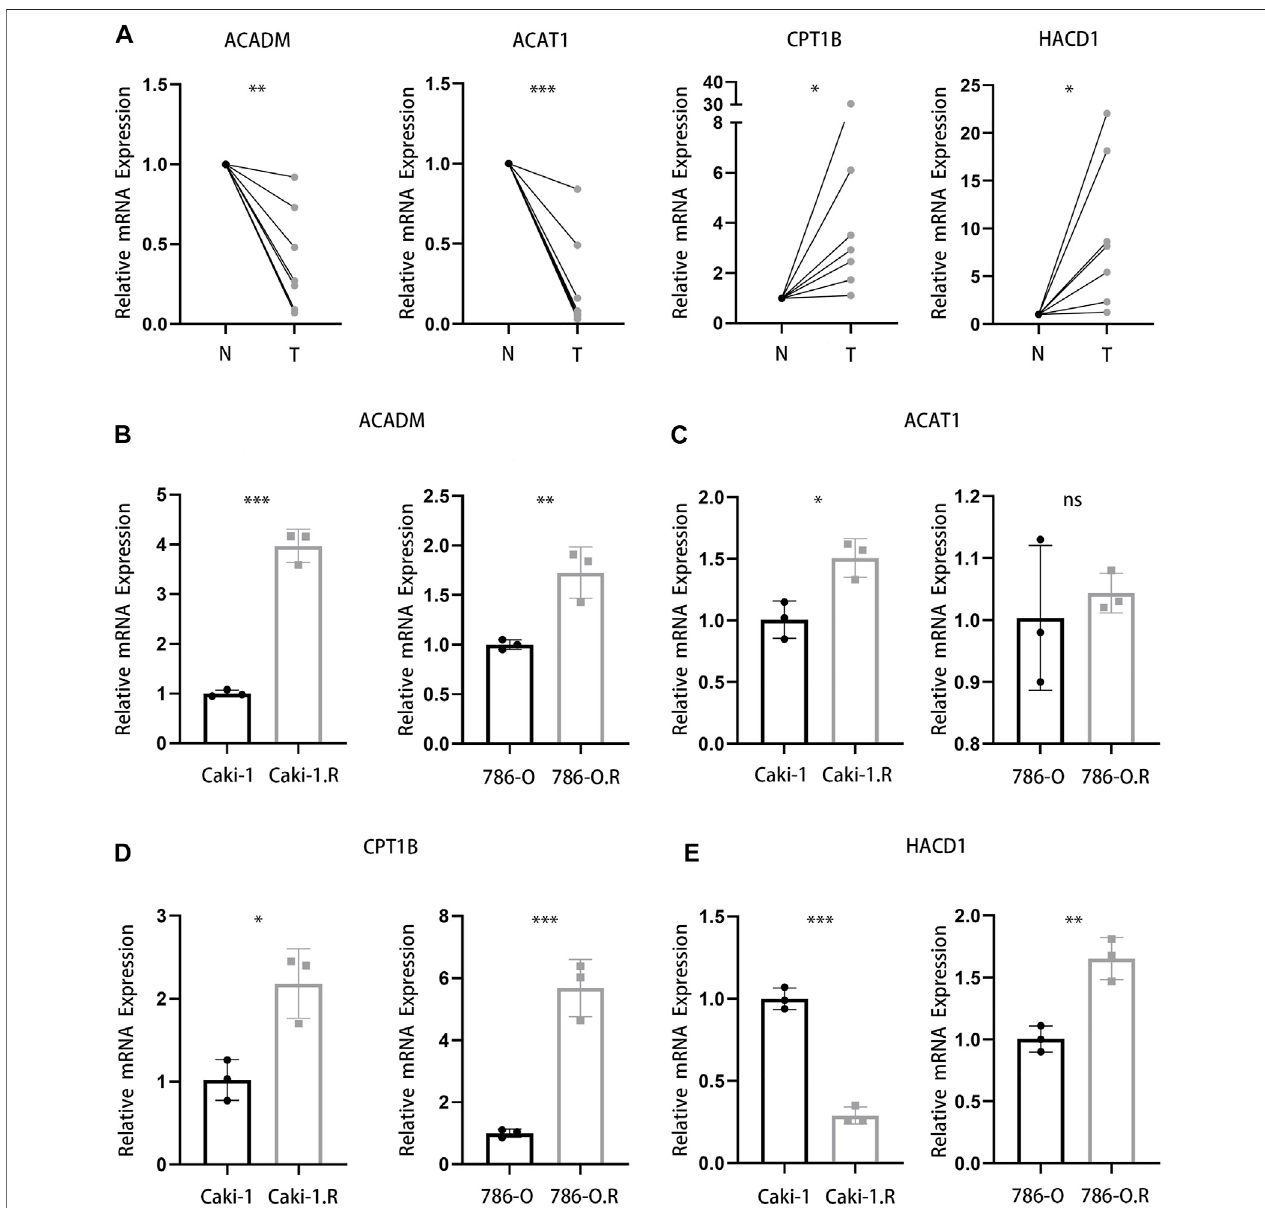
FIGURE 10 | Validation of four genes in clinical samples and cell lines. (A) mRNA expression of ACADM, ACAT1, CPT1B, and HACD1 in clinical ccRCC and para- carcinoma samples. (B – E) mRNA expression of ACADM (B) , ACAT1 (C) , CPT1B (D), and HACD1 (E) in Caki-1, 786-O, and respective sunitinib-resistant cell lines.